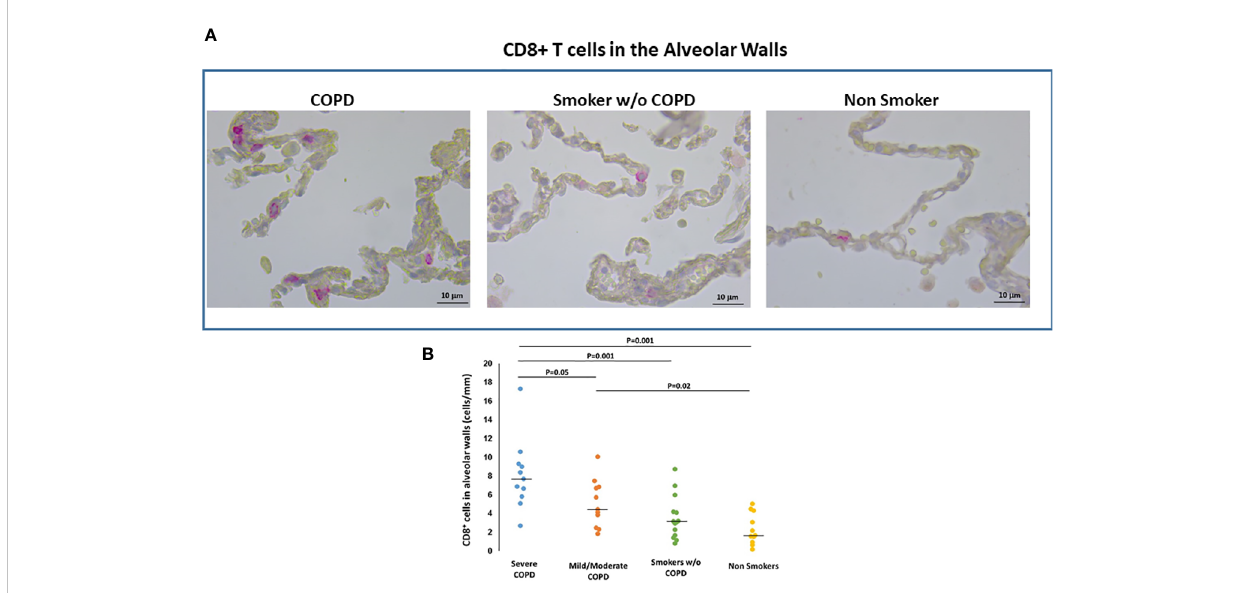
FIGURE 4 CD8+T cells in the alveolar walls. (A) Immunohistochemistry of CD8+ cells in the alveolar walls in smokers with and without COPD and non- smokers. CD8 immunoreactivity appears as a diffuse red color at the cytoplasmic level. (B) Number of CD8+ cells/mm of alveolar wall in smokers with severe COPD (blue circles), mild/moderate COPD (orange circles), smokers without COPD (green circles) and non-smokers (yellow circles). Horizontal bars represent median values. Overall comparison by Kruskal-Wallis test (p<0.001) with Dunn ’ s multiple comparison